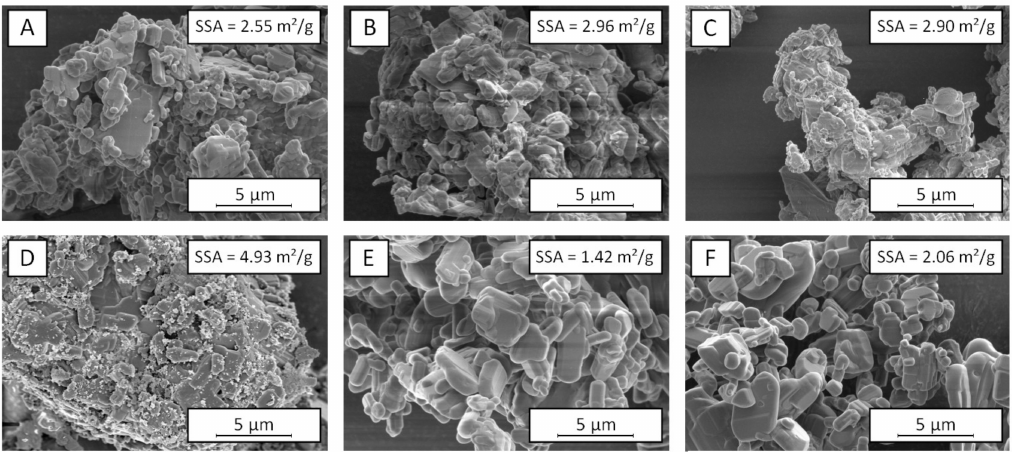
Figure 7. SEM images of ground theophylline (to a final particle size of x 50 = 5 µ m) with different additives and their specific surface areas (SSA) calculated from octane-BET measurements using iGC: ( A ) stabilized with 1.0 wt.% SSF, ( B ) stabilized with 3.0 wt.% SSF, ( C ) stabilized with 5.0 wt.% SSF, ( D ) stabilized with 1.0 wt.% Aerosil, ( E ) stabilized with 0.1 wt.% PEG, ( F ) stabilized with 0.1 wt.% HepAc. Magnification 20,000 × ,